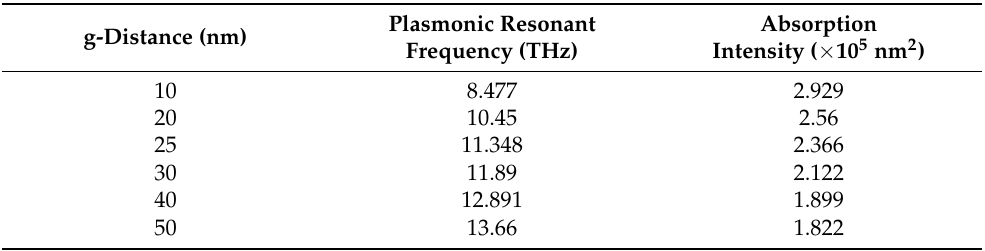
Figure 6. The influence of g variations on ACS of proposed perfect absorber. Table 6. Variations of absorption characteristics under change of the distance two ribbons in two sides of the structure (g-distance).